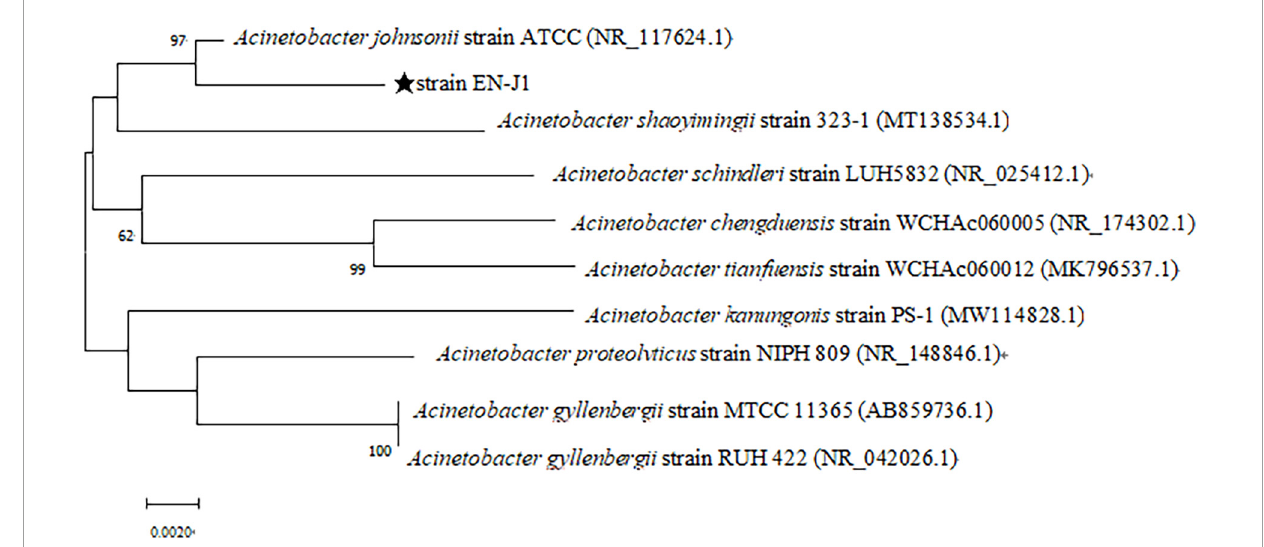
FIGURE2 Neighbor-joining phylogenetic tree of the strain EN-J1 was structured based on its 16S rRNA gene sequence and other related strains